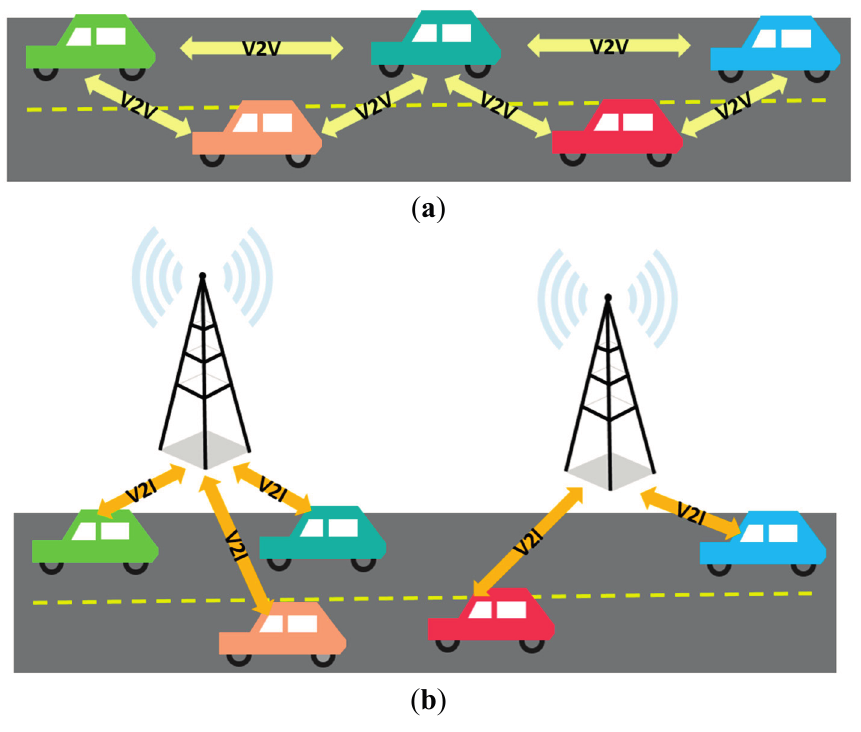
Figure 2. Representation of V2V and V2I technologies. ( a ) V2V communication; ( b ) V2I